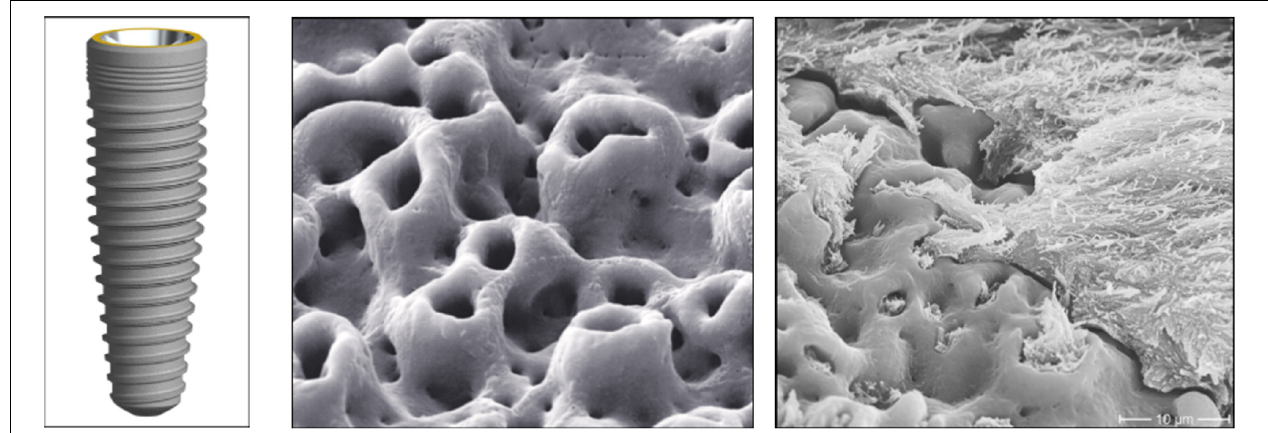
FIGURE 6 | Surface features and scanning electron micrographs of a TiUnite dental implant surface.